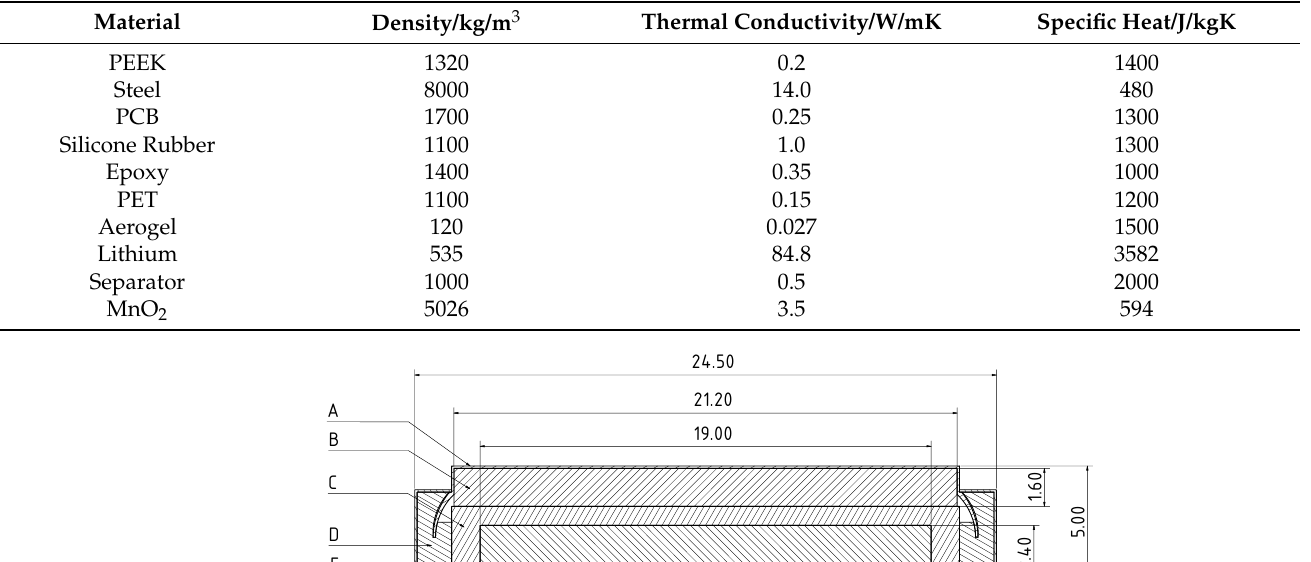
Table 2. Material properties used for thermal simulations of developed model.